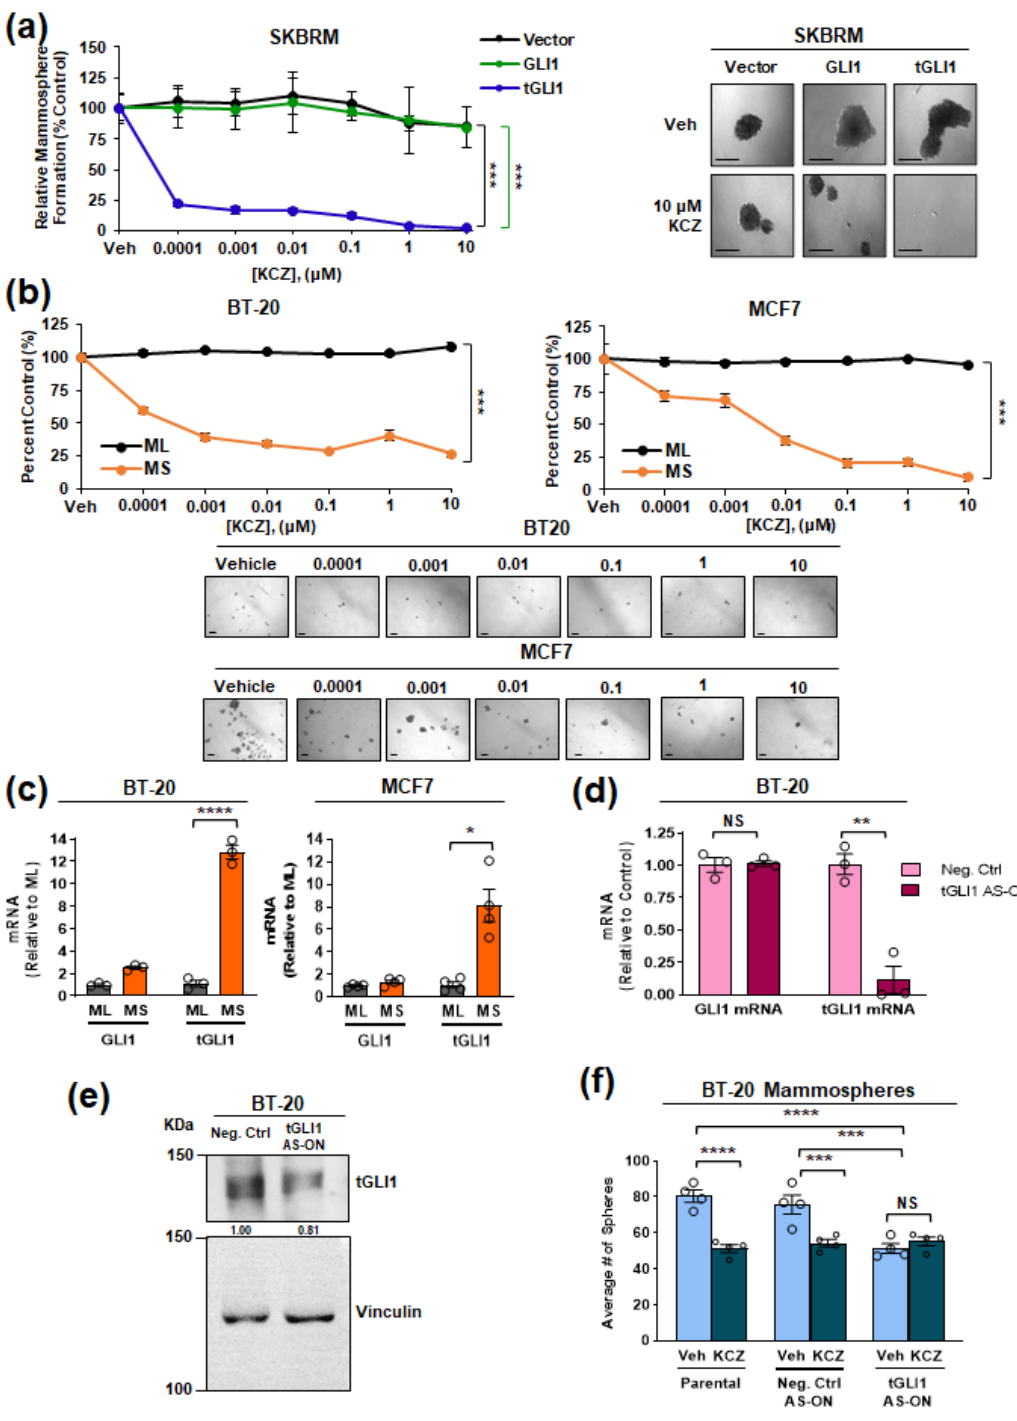
Figure 2. The tGLI1 expression is required for the KCZ-induced suppression of breast CSCs. ( a ) Mammosphere formation of SKBRM stable cell lines after 7 days of treatment (left). Representative images of mammospheres at day 7 (right). Scale bar represents 200 μ m. ( b ) KCZ activity against parental breast CSCs expressing endogenous tGLI1 and the total cell population. Parental BT-20 (left) and MCF7 (right) were grown concurrently as mammospheres (MS, orange) or monolayers (ML, black) and treated with KCZ (top). ML viability was determined by CellTiter-Blue ® Viability assay while the number of spheres was used to assess the CSC subpopulation. Representative images of BT-20 or MCF-7 mammospheres after KCZ treatment (bottom). Scale bar represents 100 μ m. ( c ) GLI1 and tGLI1 expression in BT-20 (left) and MCF7 (right) MS relative to the ML. ( d ) GLI1 and tGLI1 mRNA expression in BT-20 cells transfected with a tGLI1 antisense oligonucleotide (AS-ON)